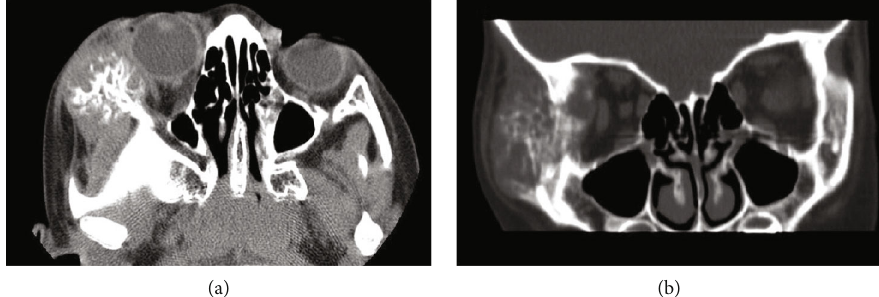
Figure 1: (a) Axial and (b) coronal noncontrast computed tomography (CT) of the orbit of an osteolytic lesion with a large soft tissue component involving the right frontal and lateral orbit and zygomatic arch. A sunburst- or honeycomb-type pattern of new bone formation is seen.